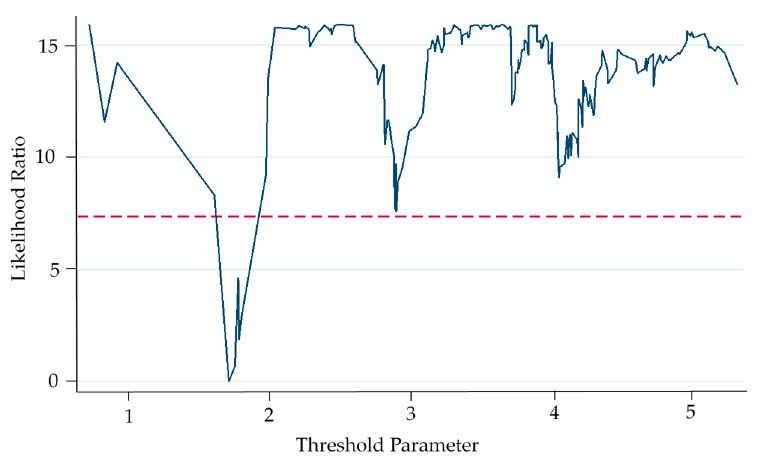
Figure 2. Single threshold regression LR test residue (ln cac ).